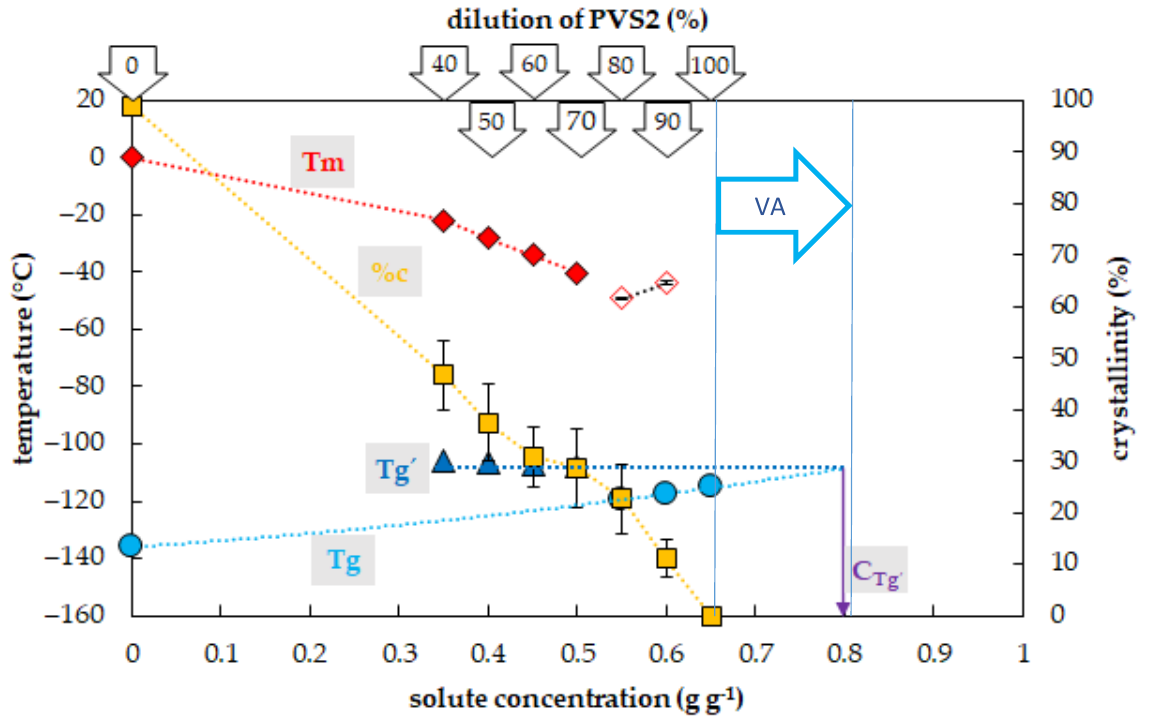
Figure 1. Thermal characteristics of osmotic components of the Plant Vitrification Solution 2 (PVS2). The x -axis expresses the total concentration of solutes (g) per mass of aqueous solution (g). The left y -axis indicates the temperature of thermal events, the right y -axis shows the percentage of water crystallinity on the total mass of solution. The temperature of the glass transition (Tg) of the solution is indicated by a cyan circle, the temperature of the glass transition Tg’ of the freeze-concentrated solution is indicated by a blue triangle, the onset of the water melting peak (Tm) is indicated by a red diamond if the effect occurs during the cooling period, the onset of the water melting peak is indicated by a hollow diamond if the effect occurs during the warming period. The percentage of water crystallinity (%c) based on the total mass of the solution is indicated by an orange square. The Cg’ value marks the concentration of the freeze-concentrated solution. The vitrification ability (VA) demonstrates the range of solute concentrations with the appropriate vitrification ability. All effects were measured during the warming period of C/W cycles at a rate of 10 °C min − 1 . Results are presented as a mean of three repetitions and vertical bars represent standard error.